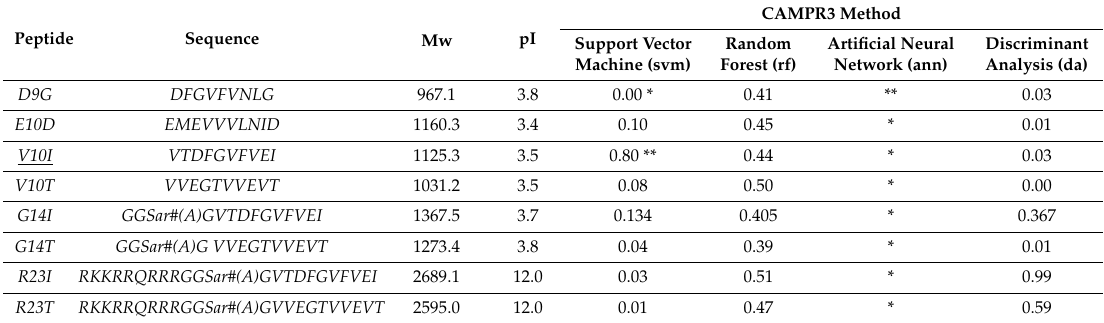
Table 1. Antimicrobial prediction for test peptides.